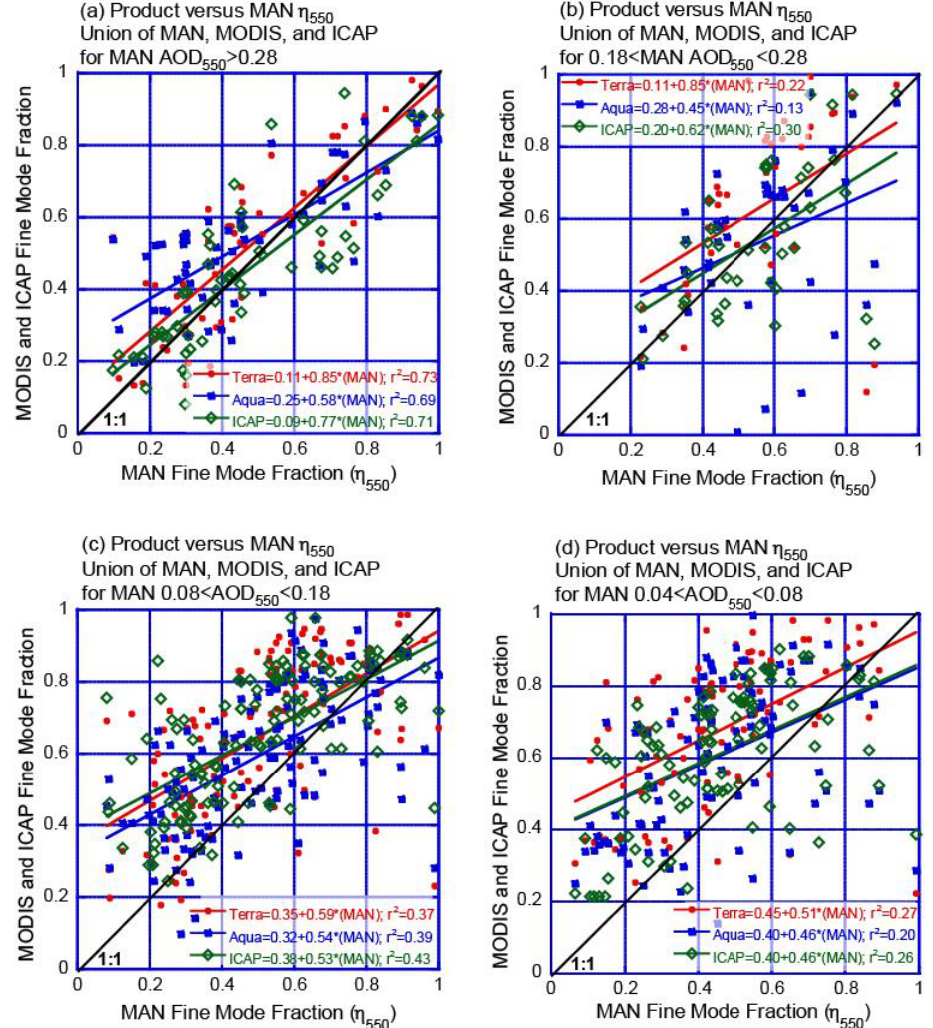
Figure 8. Scatter plots of MODIS and ICAP consensus η 550 products to corresponding MAN data (within 1° and +/ −2 h), only when both Terra and Aqua match to the same MAN data point. Therefore, those data points where and when there is a union of all sensors and the ICAP consensus. Included are 4 AOD 550 ranges, (noting that the median and 84th AOD 550 in the MAN dataset is 0.08 and 0.28, respectively): ( a ) AOD 550 > 0.28; ( b ) 0.18 < AOD 550 < 0.28; ( c ) 0.08 < AOD 550 < 0.18; ( d ) 0.04 < AOD 550 < 0.08.